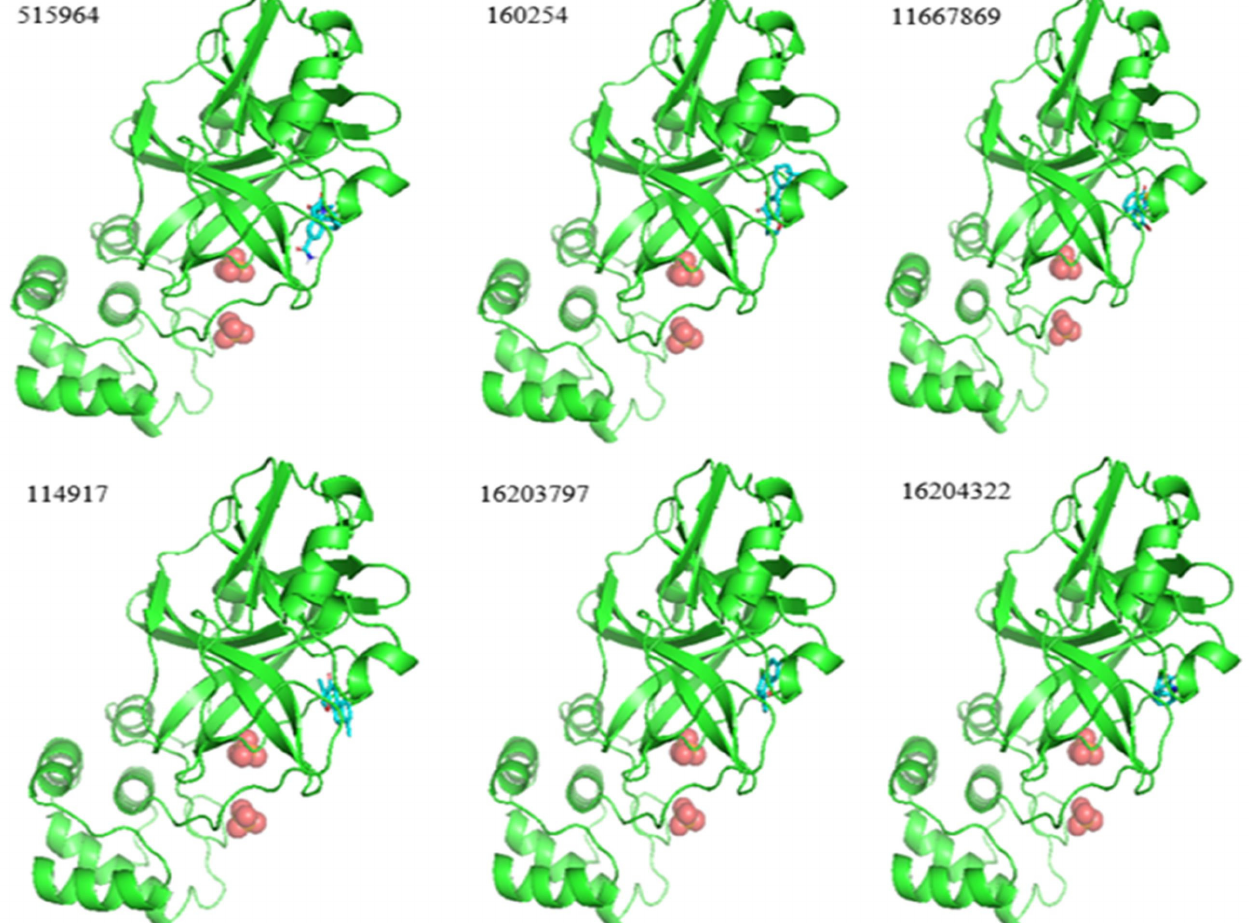
Figure 5. Best pose of six bioactive molecules towards the target protein 7JSU.